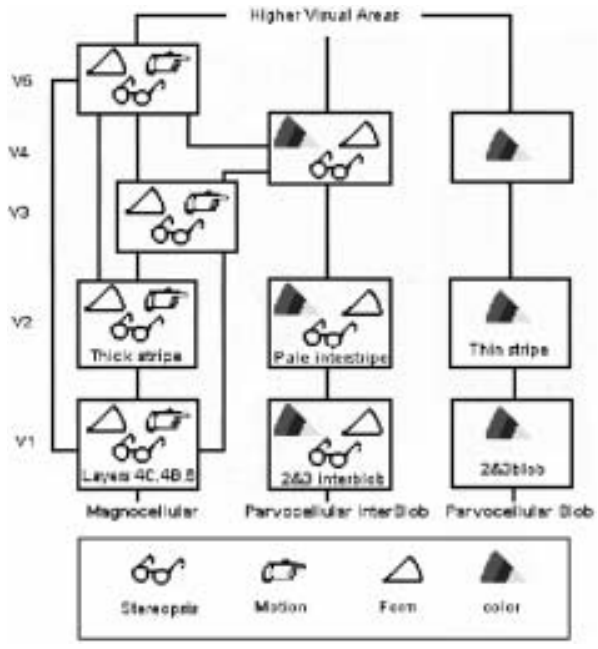
Figure 4 Parallel visual pathways. Adapted from Kandel et al